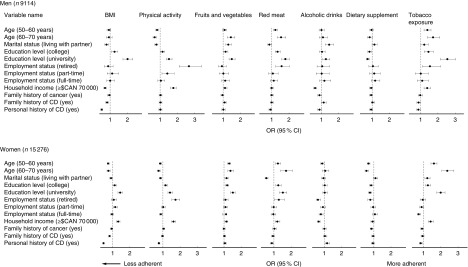
Association between adherence to individual cancer prevention recommendations and influential factors in the Alberta’s Tomorrow Project cohort, Canada, stratified by sex. Values are odds ratios, with their 95 % confidence intervals represented by horizontal bars, adjusted for age, marital status, education level, employment status, annual household income, first-degree family history of cancer, first-degree family history of chronic disease (CD) and personal history of CD. The reference levels for estimated variables are: age (≥35 to <50 years), marital status (living without partner), education level (high school education or lower), employment status (not employed), annual household income (<$CAN 70 000), first-degree family history of cancer (no), first-degree family history of CD (no) and personal history of CD (no)